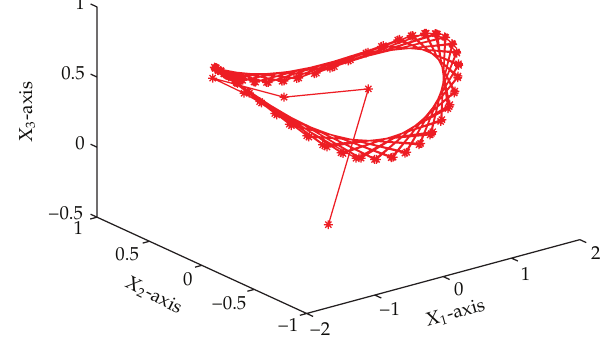
Figure 2: Phase response of state variables x 1 ,x 2 , and x 3 in Example